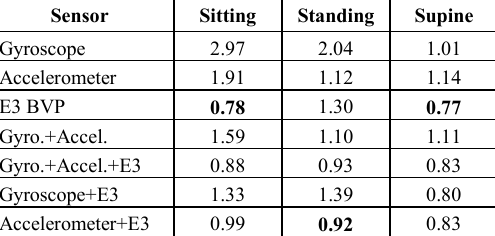
TABLE I. H EART R ATE E STIMATION ( N : 594) Sensor